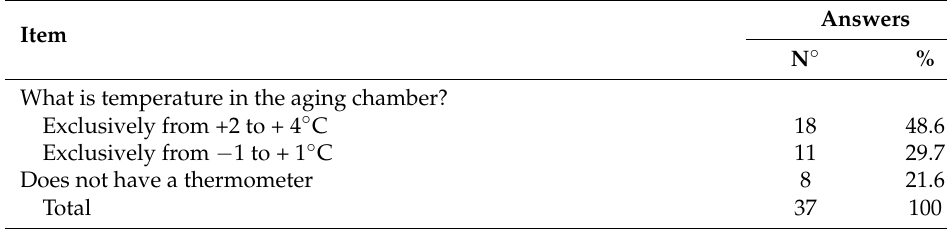
Table 5. Conditions of dry-aged meat production process in